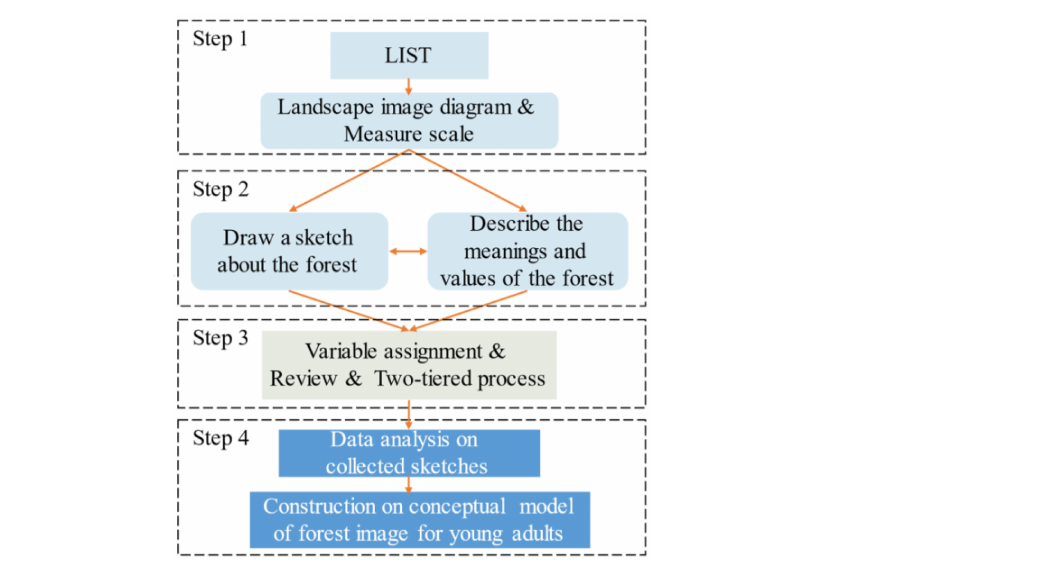
Figure 1. Main steps used to construct a conceptual model of forest-landscape image for young adults.